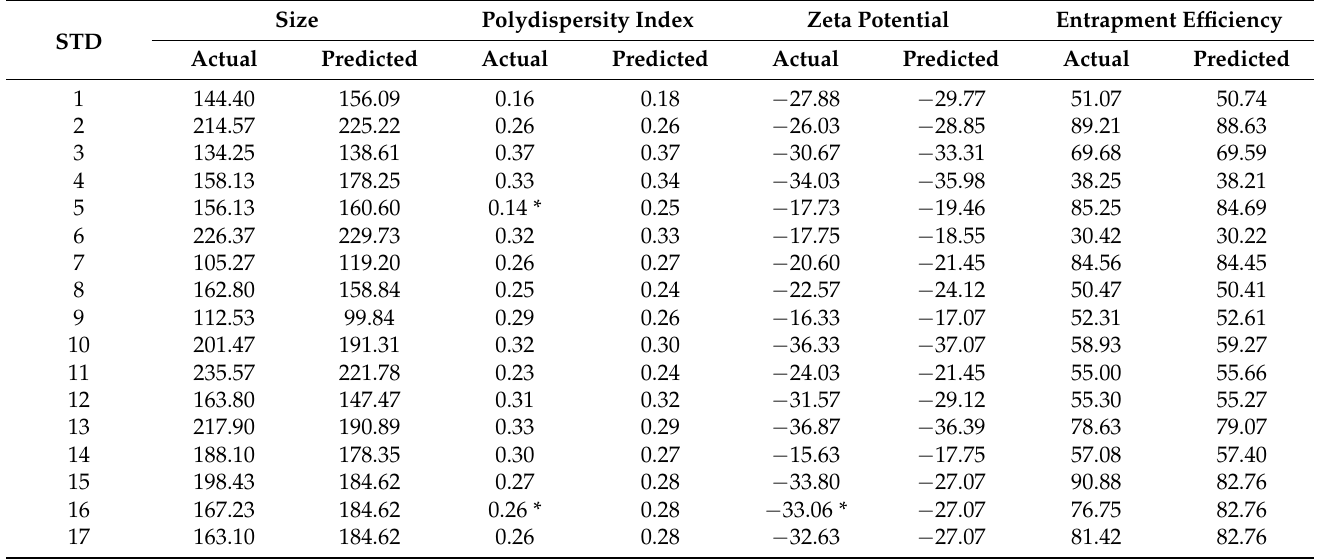
Table 2. The predicted and observed values for size, polydispersity index, zeta potential, and entrapment efficiency. * Excluded from the